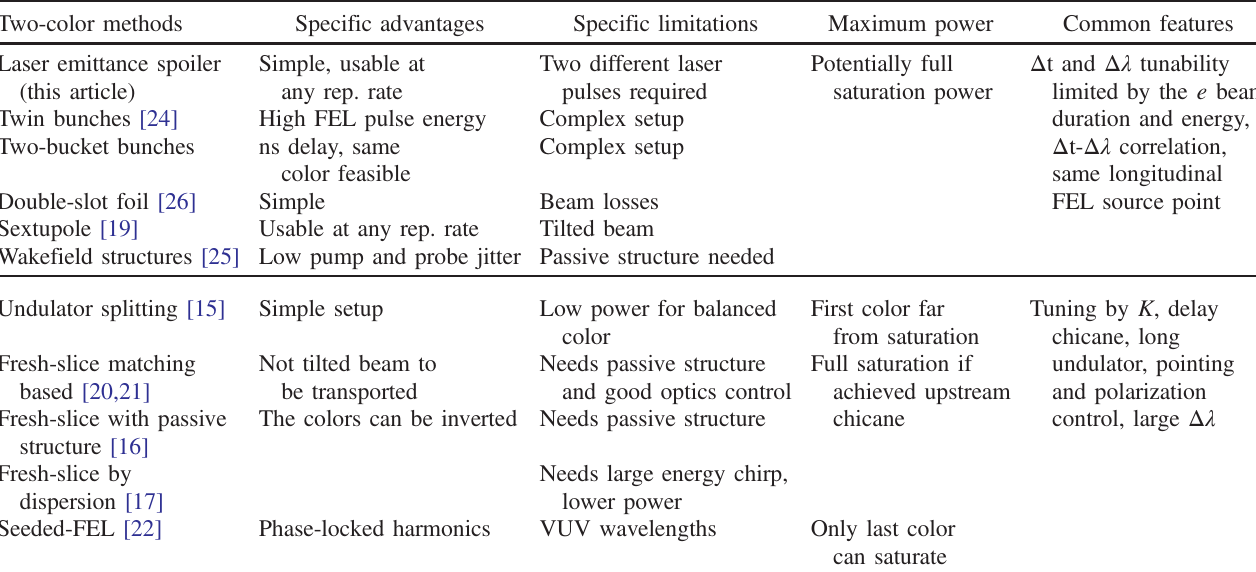
TABLE I. Laser emittance spoiler and other two-color x-ray FEL methods demonstrated in literature. The top part of the table refers to the two-color FEL based on the manipulation of the electron beam while the bottom rows on the tuning of the undulator K. Δ t and Δ λ are the delay between the two-color pulses and their wavelength separation respectively.